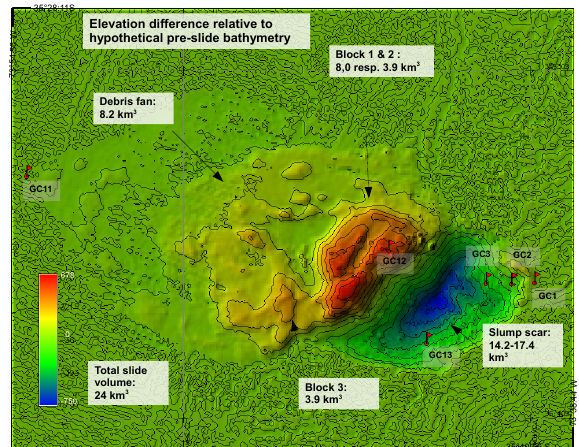
Fig. 7. Elevation difference between present day bathymetry of Reloca Slide and pre-slide bathymetry. The differential elevation shows, where most material was removed respectively deposited. The main blocks represent 2/3 of the total slide volume, 1/3 was spread in the form of a debris fan. According to the model, sedi- ments at coring locations GC2-3 and GC13 were subject to overbur- den pressure of a rock column of 150–350m height. At the center of the headscarp, ∼ 700m of rock were